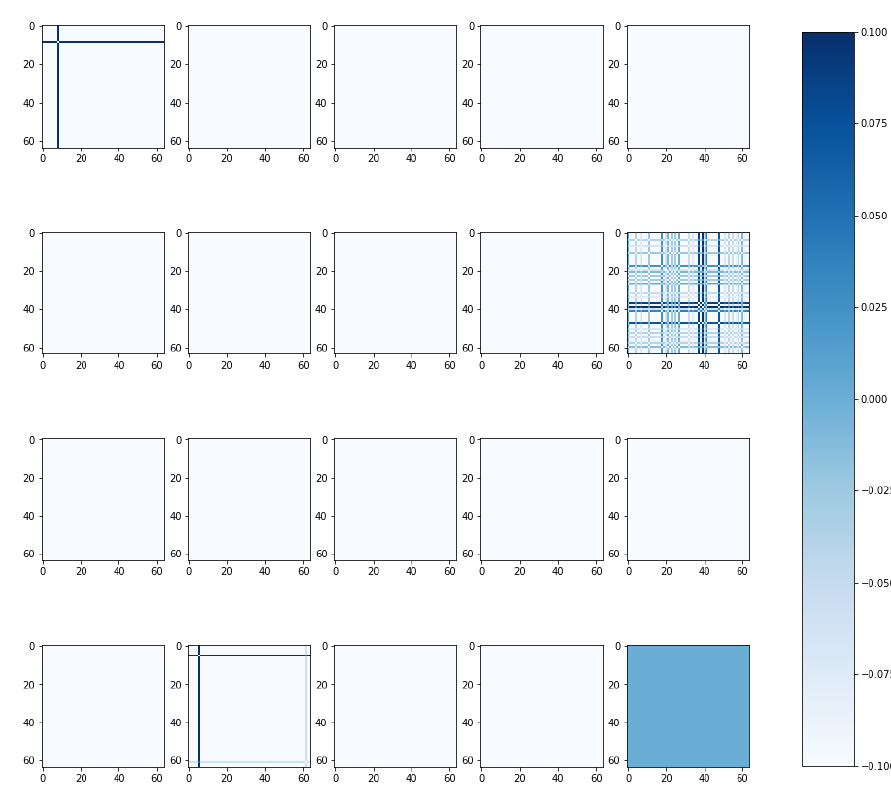
Figure A3. The 20 Recurrence Plots of an interlock sample.